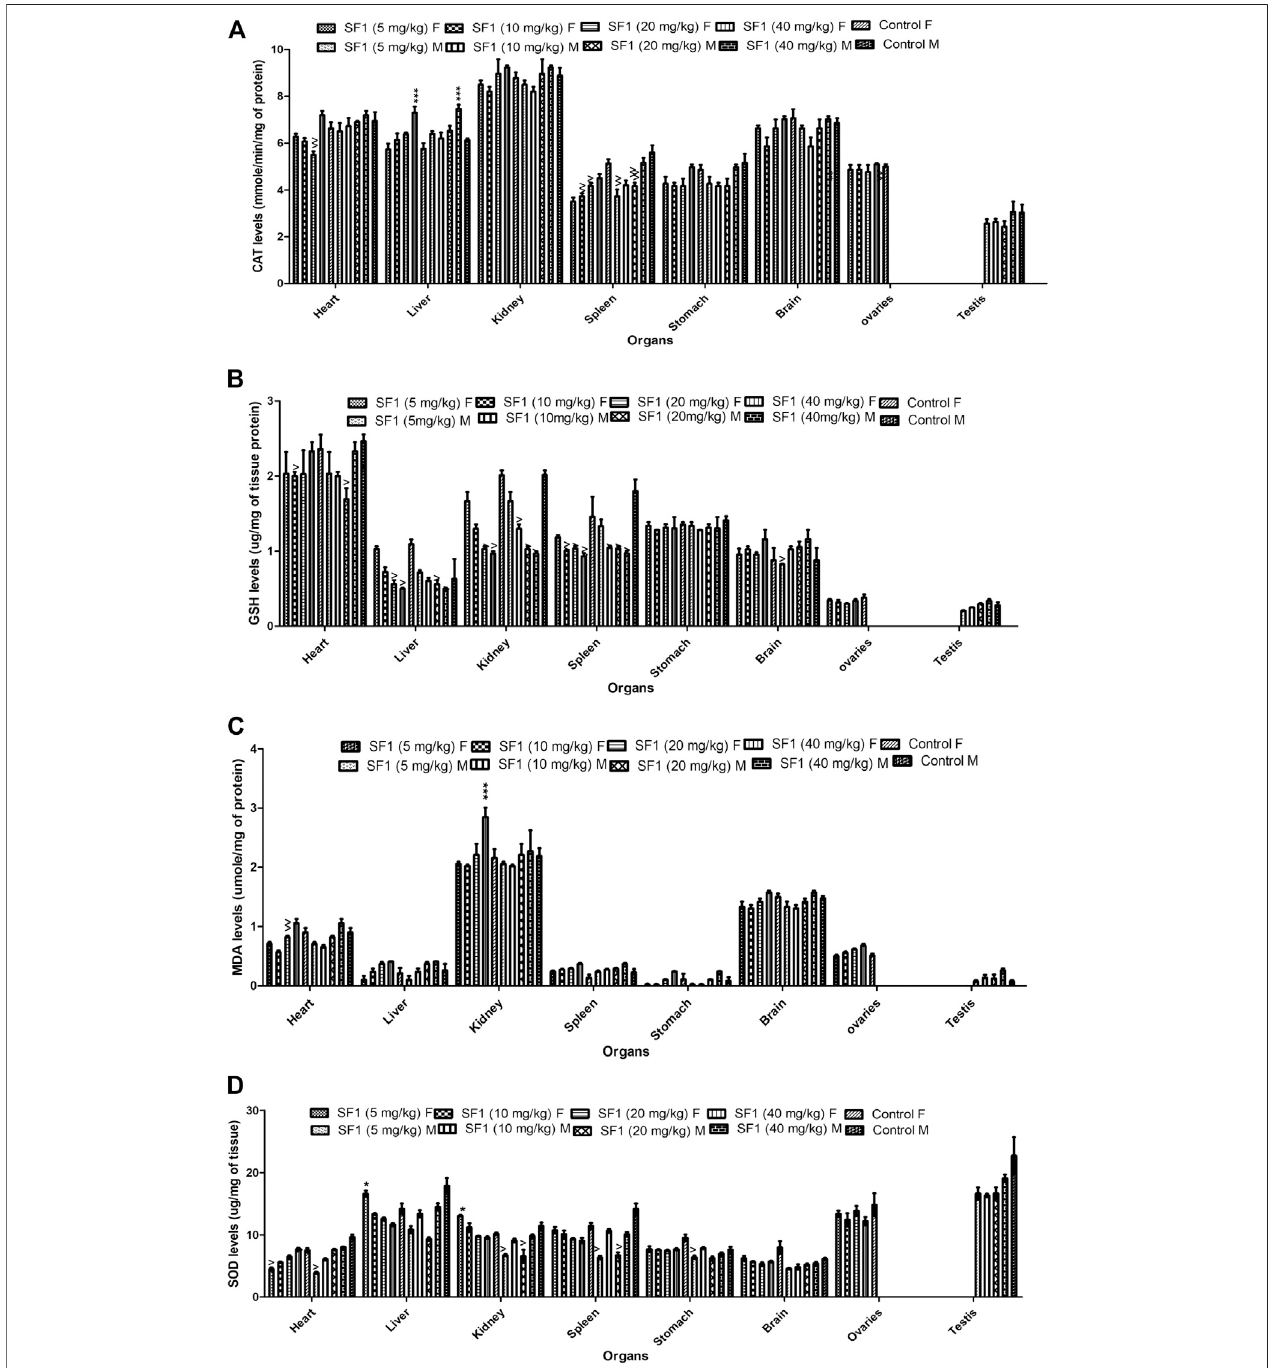
FIGURE 7 | Estimation of oxidative stress markers in the subacute toxicity study in male and female rats. The data is presented as mean ± SEM ( n (cid:1) 3). * p < 0.05 and ^ p < 0.05 were increased and decreased levels of signi fi cance, respectively, in comparison to the control. M (cid:1) Male, F (cid:1) Female.